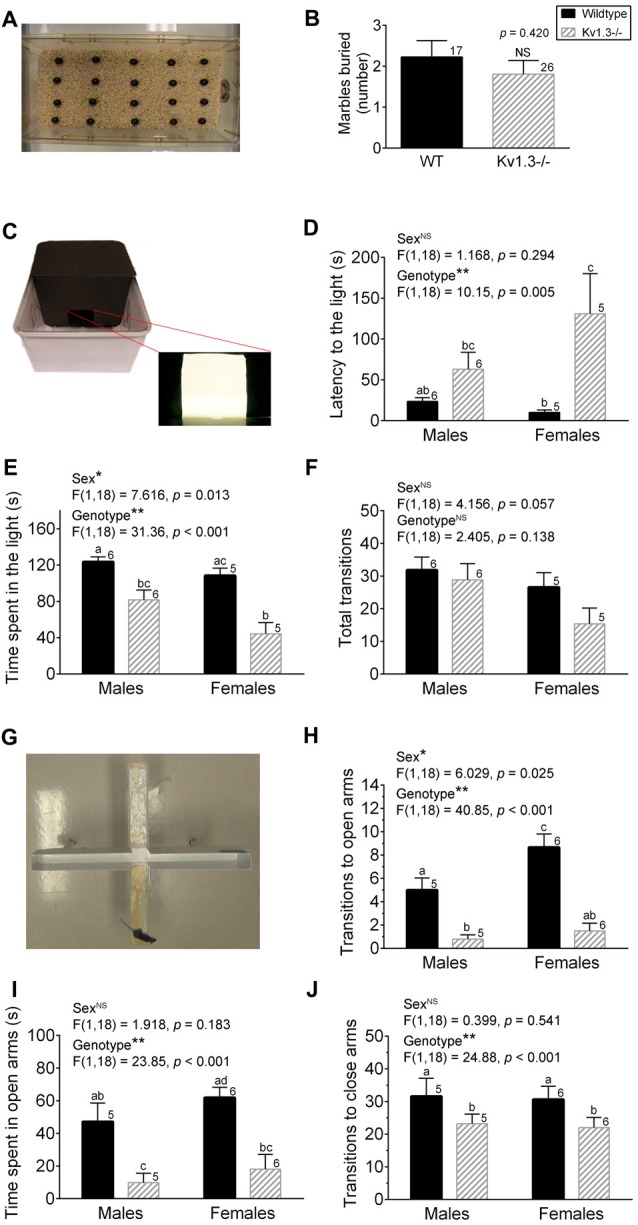
Kv1.3−/− mice exhibit increased anxiety in the light-dark box (LDB) and elevated-plus maze (EPM) apparatus. (A) Photograph of the buried marble (MB) test apparatus. (B) Bar graph of the number of marbles buried by male wild-type (WT) vs. Kv1.3−/− (Kv1.3−/−) mice. Student’s t-test. (C) Photograph of the LDB test apparatus. (D–F) Bar graphs of the latency to movement to the light box (D), the time spent in the light box (E) and the number of transitions between boxes (F) comparing WT vs. Kv1.3−/− mice. Two-way analysis of variance (ANOVA), Tukey’s post hoc test. (G) Photograph of the EPM test apparatus. (H–J) Bar graphs of the number of transitions to the open arms (H), the time spent in the open arms (I), the number of transitions to closed arms (J) comparing WT vs. Kv1.3−/− mice. Two-way ANOVA, Tukey’s post hoc test. (B,D–F,H–J) Significantly-different means, *p < 0.05, **p < 0.001. NS = not-significantly different. Different lower case letters indicate significantly-different means in the Tukey’s post hoc analysis with genotype and sex as factors. Bars with similar lower case letters indicate means that are not significantly different in the post hoc analysis. Number of mice per treatment group as indicated. Data represent mean plus or minus the standard error of the mean (SEM).